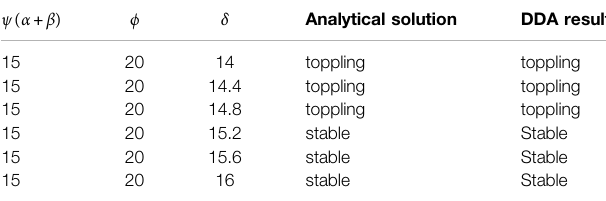
TABLE 2 | 3-D DDA results of the state of a single block on the inclined slope.